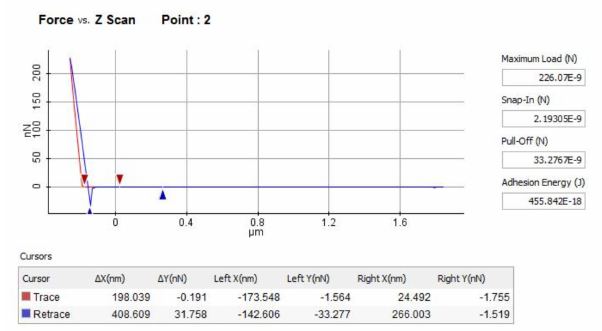
Figure 29. Adhesion forces for Si/Cr in 16th mapping area.